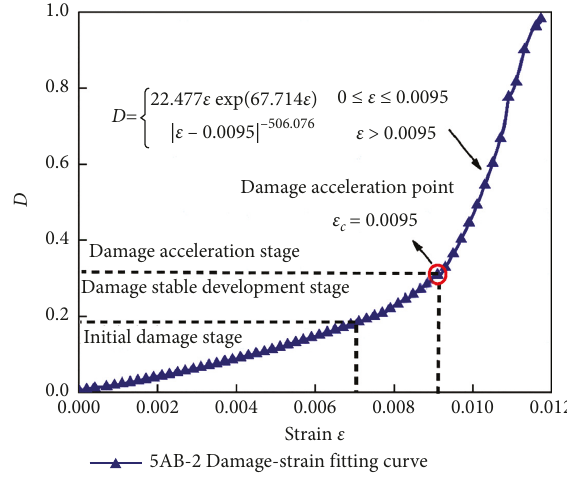
Figure 19: Damage-strain curve of 5AB-2.